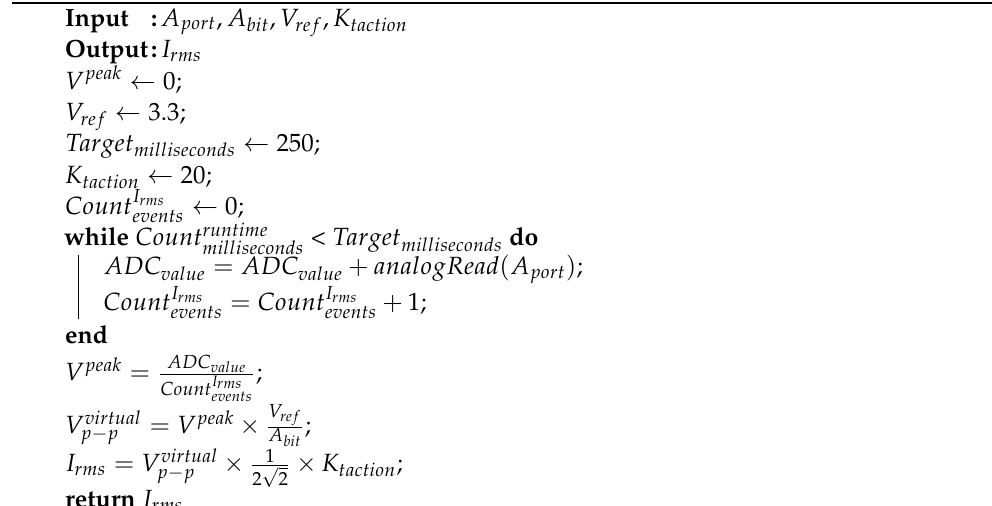
Algorithm 2: Current measurement with noise